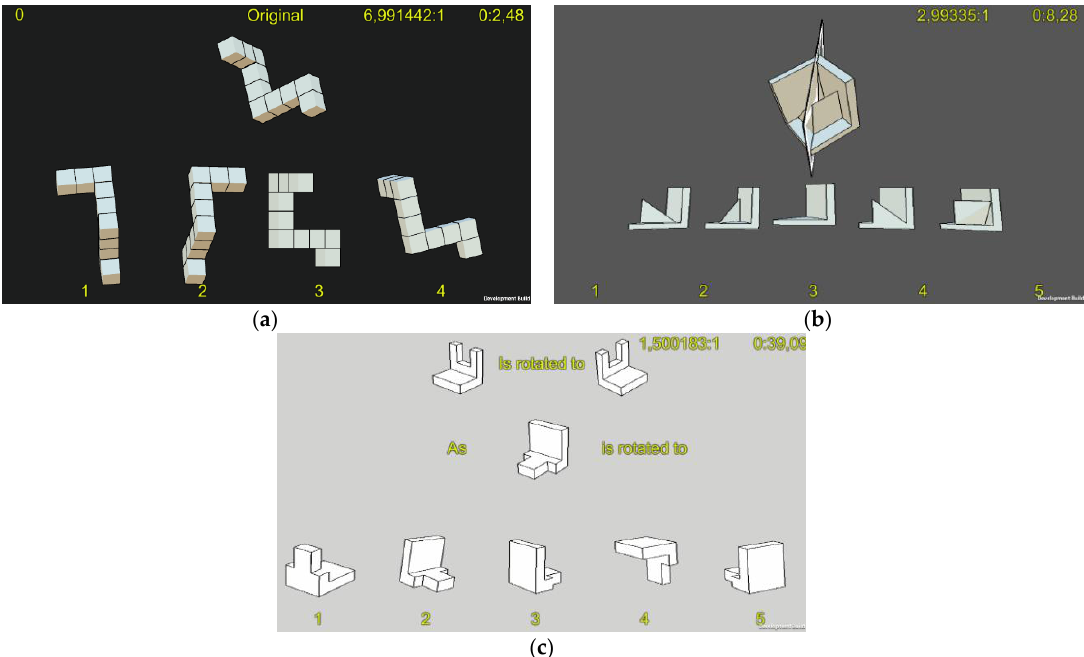
Figure 1. ( a ) The MRT test with an orthographic camera, 7:1 contrast ratio, shadows turned on and no extra rotation; ( b ) The MCT test with a perspective camera, a 60° field of view, 3:1 contrast ratio, shadows turned on and no extra rotation; ( c ) The PSVT test with a perspective camera, a 45° field of view, 1.5:1 contrast ratio, shadows turned off and no extra rotation.